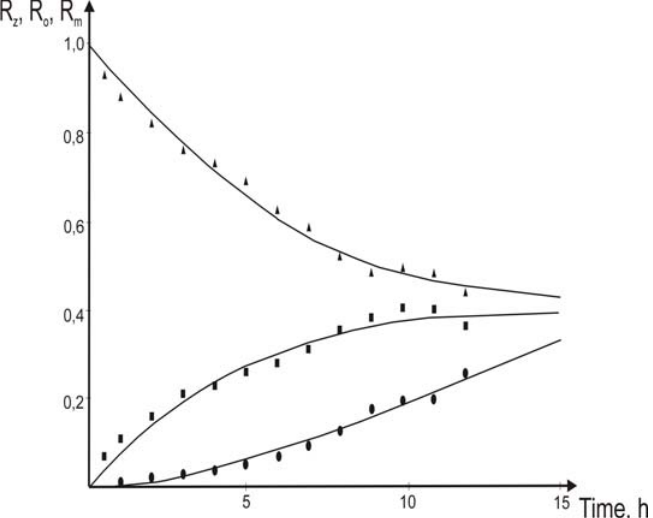
= 5.8·10 -5 mol·m -3 ( ▲ - R p